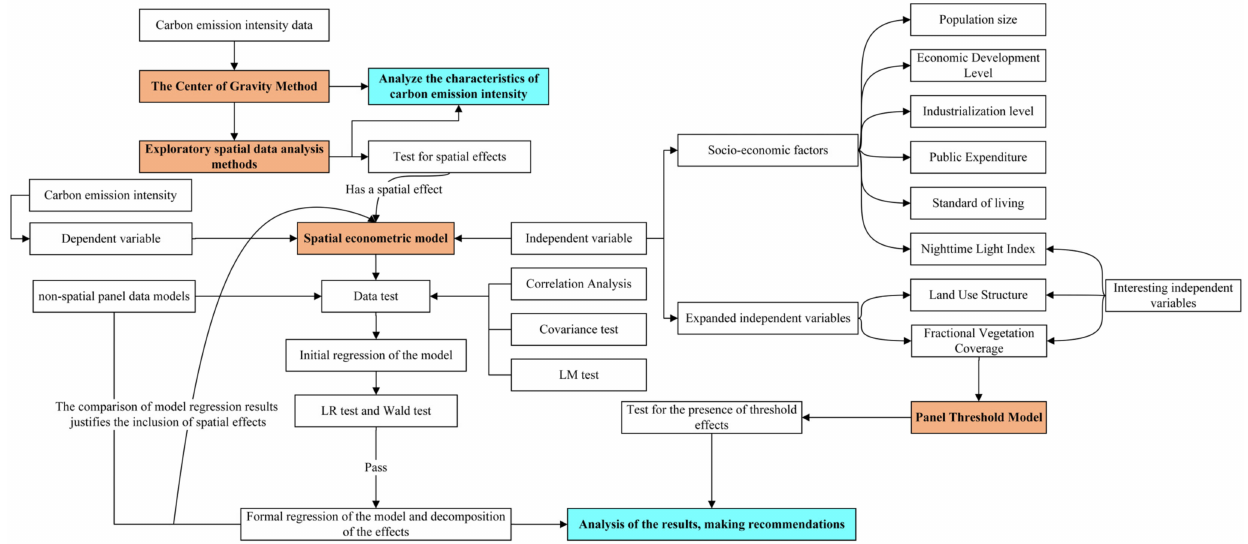
Figure 2. The research framework of this study. The orange represents the research methodology and the blue filled represents the part where the main conclusions were